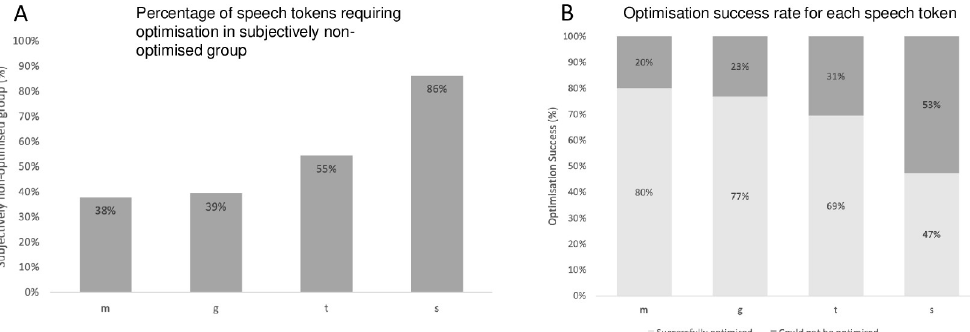
Fig 4. (A) Percentage of CAEP responses for the four speech tokens obtained from the subjectively non-optimised group. (B) Percentage of CAEPs obtained for each speech token post-CAEP guided mapping.